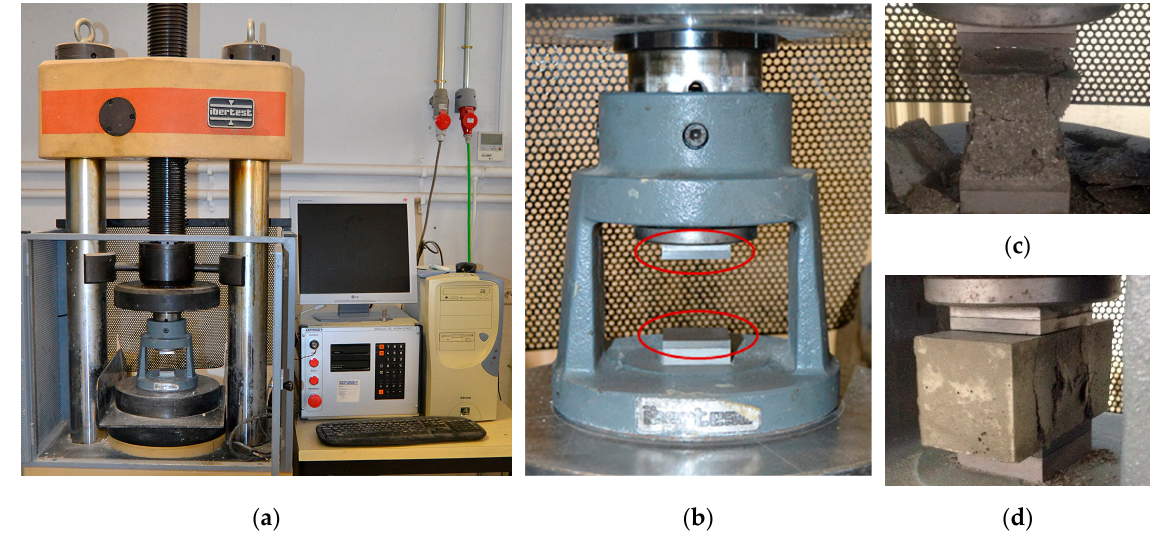
Figure 4. Compressive strength test: ( a ) hydraulic press; ( b ) device with steel supports of 40 mm × 40 mm; ( c ) test specimen fracture without fibres; ( d ) test specimen fracture with fibres.